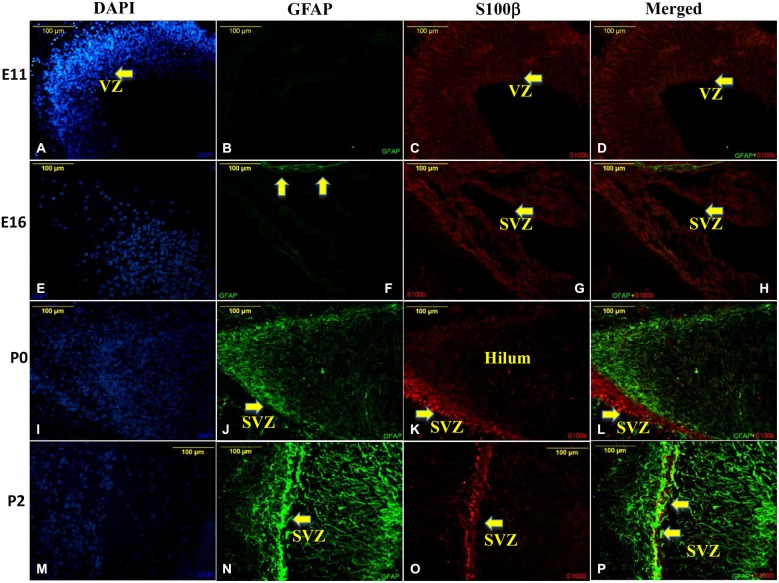
S100β labels the progenitors during embryonic and early neonatal life and differentiated astrocytes at adulthood. Double immunostaining with GFAP (green; B,F,J,N) and S100β (red; C,G,K,O) reveals appearance of GFAP at hippocampal niche at E16 (arrows; F) while uniform S100β staining in the VZ at E11 (C) and SVZ at E16 (G). At P0 a further increase in GFAP immunostaining indicates an increase in astrocyte population (J) and S100β expression is confined to the SVZ and hilum regions (K). The GFAP immunostaining does not coincide with the S100β in the merged images (D,H,L). However, at P2 some progenitors are labeled with both GFAP and S100β (arrows; P). DAPI (blue) clearly indicated the brain areas focused (A,E,I).